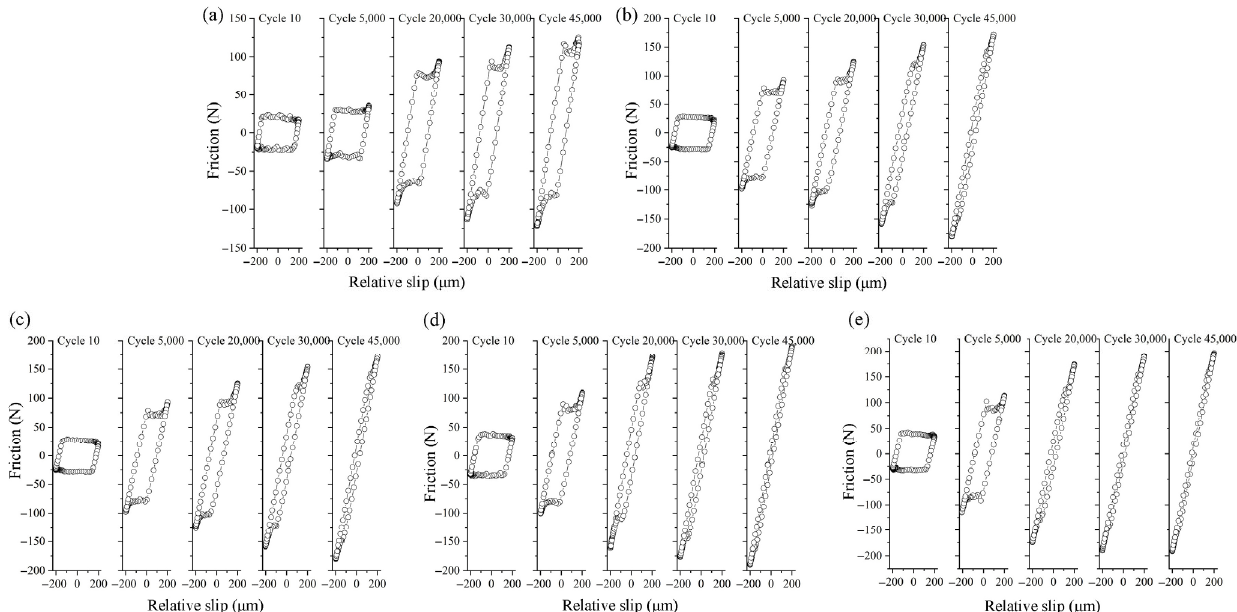
Fig. 10 Evolution of hysteretic curves under different loading conditions. (a) 120 N + 80 N, (b) 120 N + 160 N, (c) 120 N + 240 N, (d) 150 N + 240 N, and (e) 180 N + 240